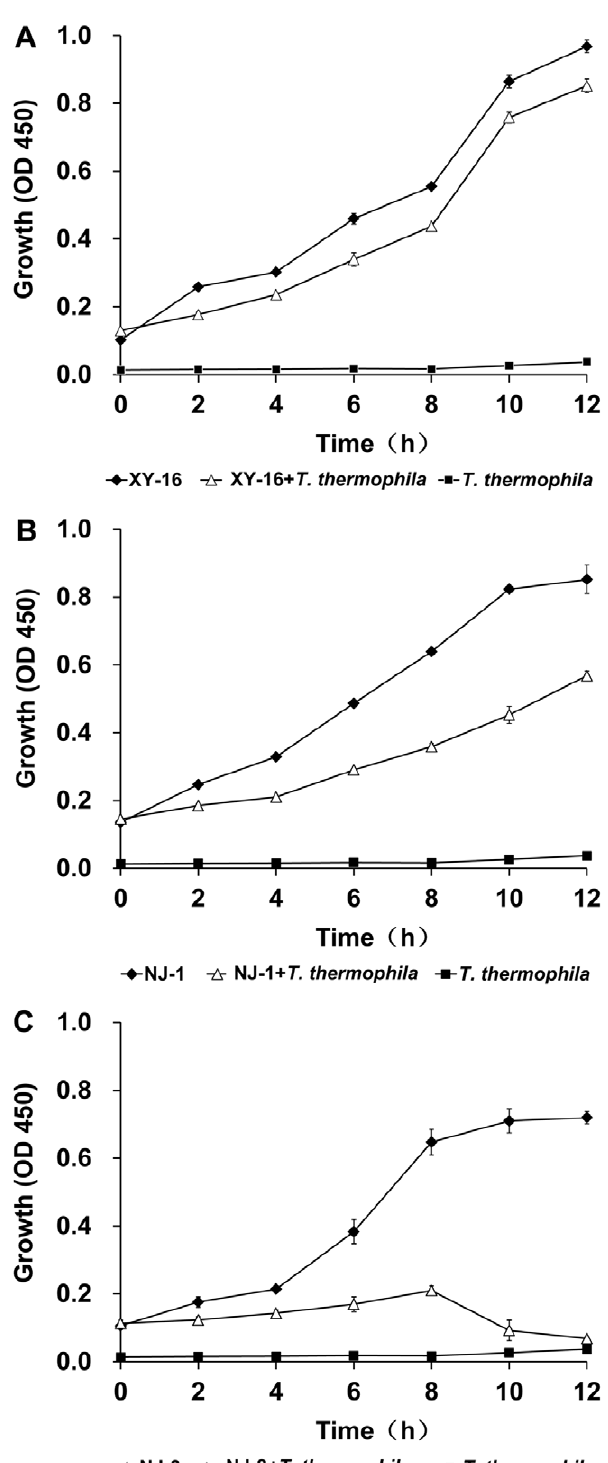
Figure 2. Growth of A.hydrophila XY-16 (A), A.hydrophila NJ-1 (B) and A.media NJ-8 (C) co-cultured in the presence or absence of T.thermophila. Bacterial growth was determined by measuring the absorbance at 450 nm (A 450 ) during 12 h and ( T. thermophila cells had only a negligible effect on A 450 ). Data are expressed as the mean 6 SD of four observations per time